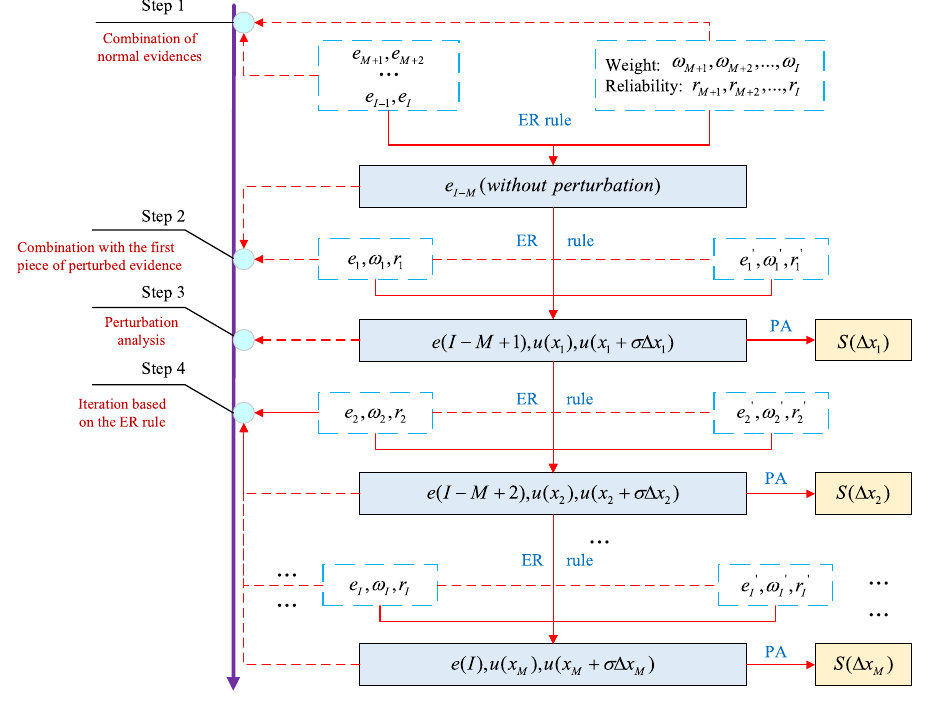
Figure 3. The overall process of ER